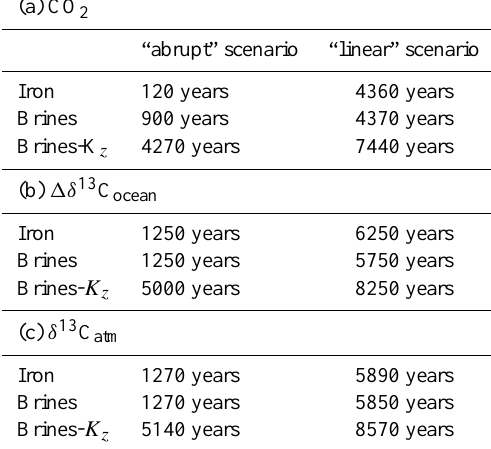
Table 2. Time for the anomaly of the considered variable (defined as the difference between its value and the initial value) to reach 95% of the equilibrium anomaly value (equilibrium anomaly value taken as the difference between the value at year 12000 of the sim- ulations and the initial value) under a constant glacial climate for (a) CO 2 , (b) 1δ 13 C ocean , and (c) δ 13 C atm . “Iron” corresponds to iron fertilization, “Brines” to the sinking of brines, and Brines- K z to the sinking of brines and interactive diffusion. The two scenarios for iron fertilization and the sinking of brines (“abrupt” and “lin- ear”) are defined in Fig. 1.